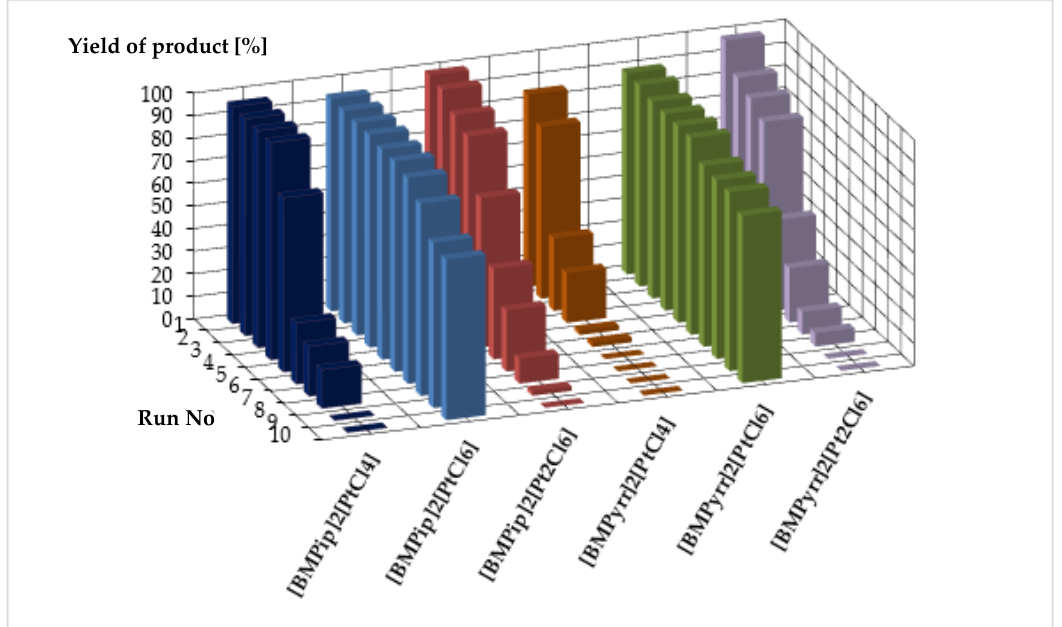
Figure 5. Yields of the product of hydrosilylation of allyl glycidyl ether with 1,1,1,3,5,5,5-heptamethyltrisiloxane as determined for 10 subsequent reaction cycles catalyzed by the same catalyst portion.